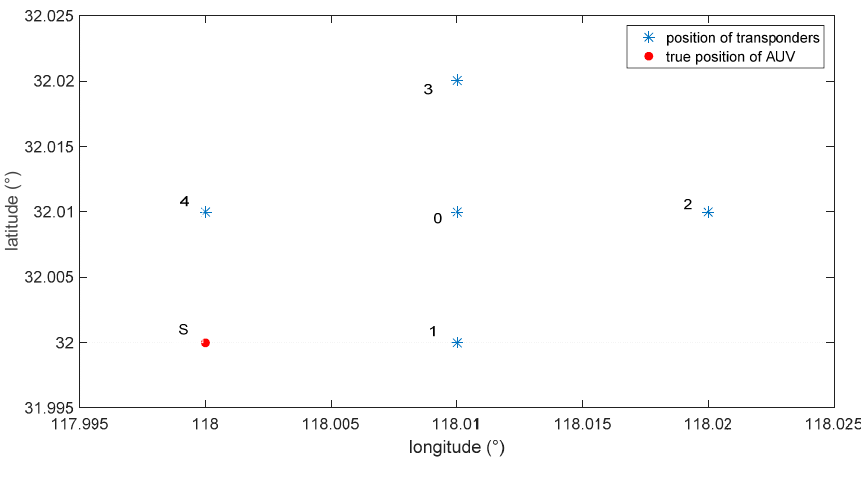
Figure 16. Layout of the hydrophones and the AUV.